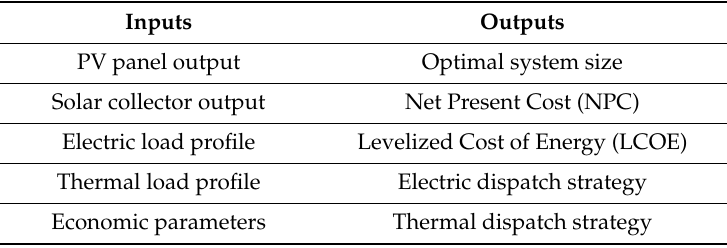
Figure 3. Schematic representation of the integrated electric and thermal energy system model. The thermal energy system is not a single centralized entity but rather the aggregate of multiple user-scale individual systems, which are modeled for each user within each user class and only connected through the electricity grid, in the absence of a heat distribution network. Table 1. Main inputs and outputs of the Multi-Energy System